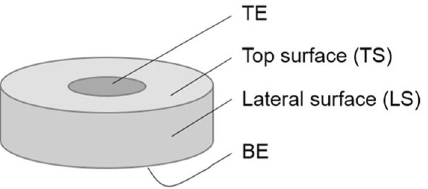
Figure 1. Geometry of the 2D rotational symmetric model. The oxide (light grey) completely covers the bottom electrode (BE), while the top electrode (TE) does not have to cover the whole top of the oxide, but can be smaller as shown